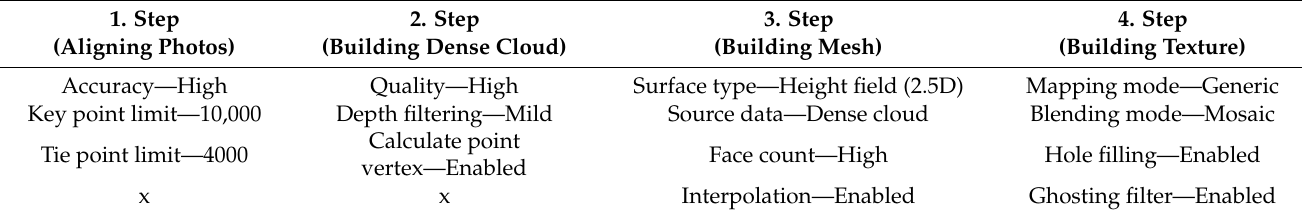
Table 2. Agisoft Photoscan Professional (64-bit) version 1.4.4